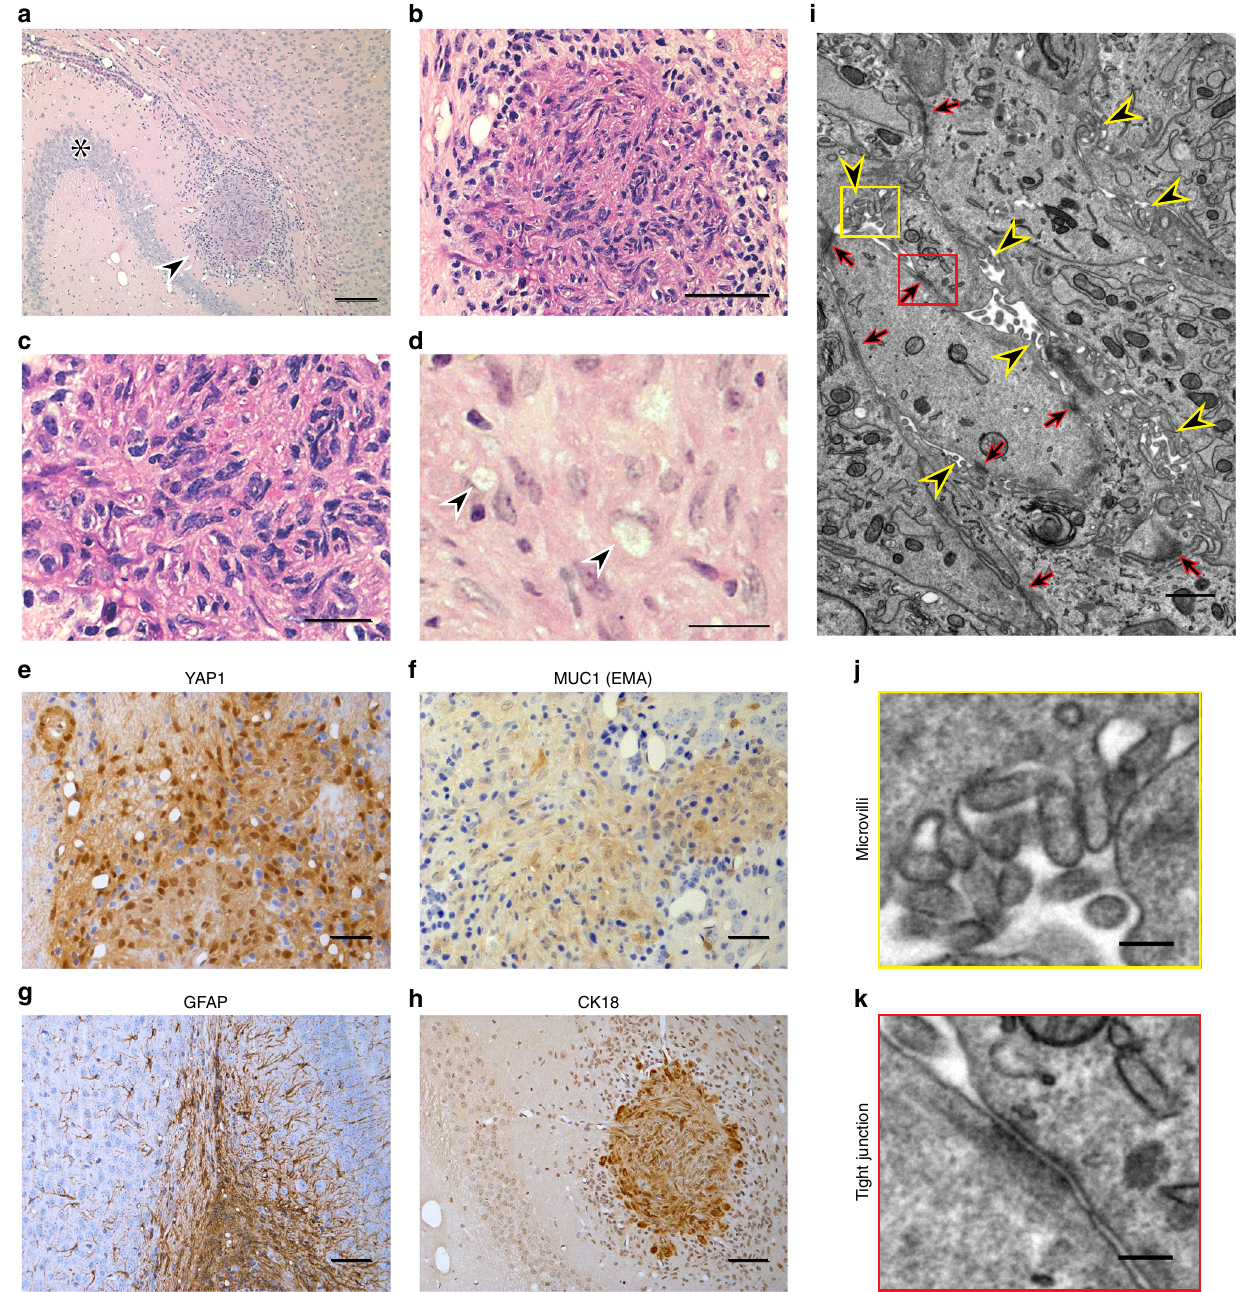
Fig. 5 LATS1/2 cKO mouse tumours display histological features of ependymoma. a – d The tumour (arrowhead) appear to arise from the ependymal layer of the anterior temporal horn of the lateral ventricle at the level of hippocampus (* CA3). a H&E, ×4, scale bar = 500 µ m; the lesion has compressive margin. b H&E, ×10, scale bar = 200 µ m and it is composed of fascicles of spindle cells with focal nuclear clustering. c . H&E, ×40, scale bar = 50 µ m. A few tumour cells contain intracytoplasmic, paranuclear vacuoles (arrowheads). d . H&E, ×60, scale bar = 20 µ m. Tumour cells demonstrate. e nuclear and cytoplasmic YAP1 expression (immunoperoxidase, ×20), f weak cytoplasmic MUC1 expression (immunoperoxidase, ×20) and g they are focally positive for GFAP (immunoperoxidase, ×20) and h cytokeratin 18/CK18 (immunoperoxidase, ×10). Reactive astrocytes surrounding the lesion are also GFAP- positive ( g — immunoperoxidase, ×20). Scale bars = 50 µ m. i TEM image (×9900) within the tumour showing multiple ependymal features (Yellow arrowheads = microvilli, red arrows = tight junctions). Scale bar = 1 µ m. j , k . Enlargement of the yellow and red insets in i , respectively. Scale bars = 200 nm. j . High magni fi cation of microvilli and k . a tight junction found in the tumour are